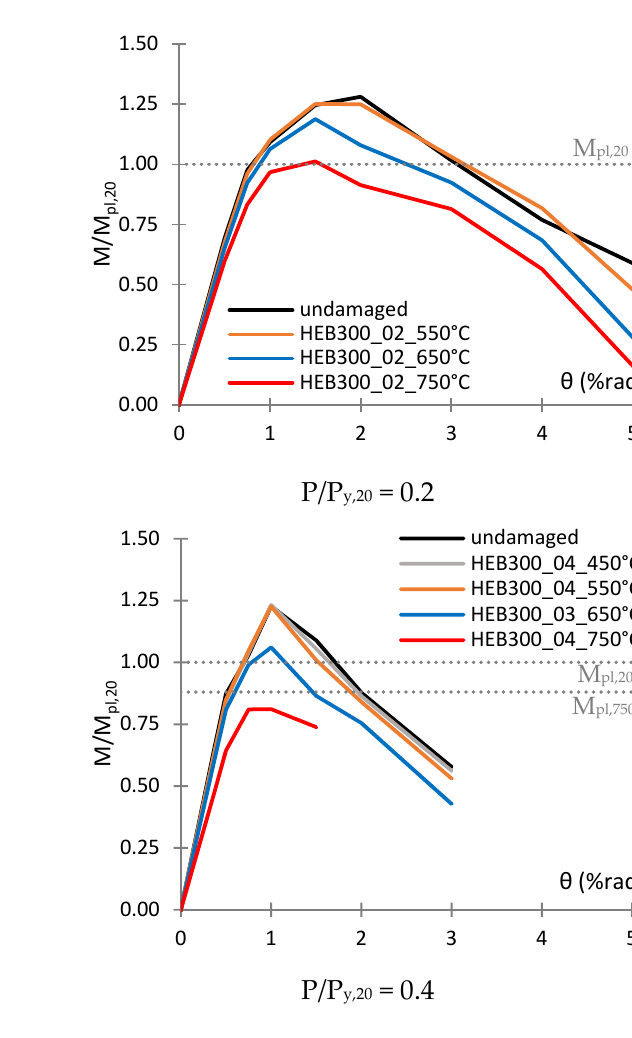
Figure 11. First cycle envelope curves for the moment M x at the base of the HEB300 columns. For the lowest loading level (P/P y,20 = 0.1) and T max = 650 ◦ C, the reduction of the Table 3. Summary of the results for the HEB300 columns. maximum moment of the first envelope curve was 7%, with respect to the undamaged column. This can be attributed to the reduced yield stress of steel (according to Equation (3) the reduction factor for the yield strength is 0.96) and the residual displacements. The maximum moment appears earlier for the damaged column ( θ Mmax = 3% and 2% for the HEB300_01_undamged and HEB300_01_650 ◦ C, respectively) and its rotational capacity ( θ Mpl,20 ) is 10% reduced (Table 3). The reduction of the flexural capacity (i.e., the maximum deduced moment of the damaged column with respect to the undamaged one) is 16% for the HEB300_01_750 ◦ C, while its rotation capacity is further reduced by 30% (Table 3). To obtain further insight into the behaviour of columns, Figure 12a,b compare